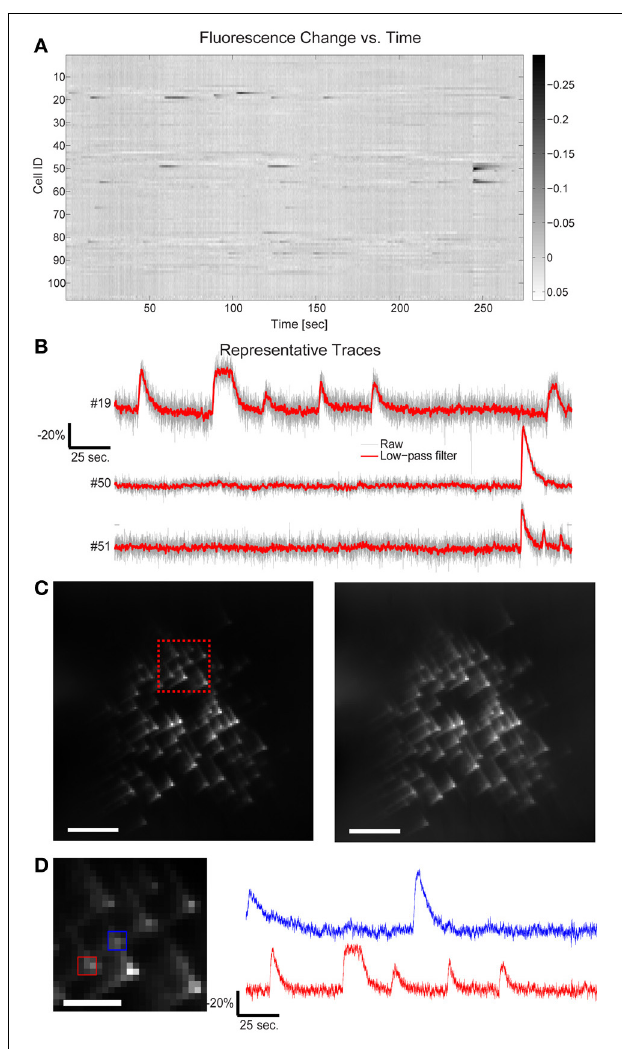
FIGURE 4 | Fluorescence change vs. time for all targets in Figure 3. (A) 109 cells have been targeted by 109 focal spots in the 3D volume and the relative fluorescence change of each targeted location is displayed. Data has been low-pass filtered by a convolution with a Gaussian filter of σ = 92ms. (B) A few representative traces indicate the SNR available by this method. (C) Five second average of the raw acquired images, illustrating both the characteristic cubic-phase aberration and the readily identifiable individual targets. Left image red inset shows area magnified in 4d, right frame is the same image, contrast adjusted to highlight dim features. Scale bar is 40 μ m in both images. (D) Magnified area of image in (C) , showing dense targeting, and again illustrating the cubic-phase aberration. Scale bar is 15 μ m. Red and blue boxes indicate ROIs used to generate traces shown on the right, using “traditional” DF/F signal extraction, without fitting. The red trace corresponds to cell #19 in (B) , and displays nearly identical absolute modulation and SNR. Note the near absence of crosstalk between the traces, although laterally, the two sources are separated by ∼ 10 μ m. Traces are low-pass filtered as in (A)